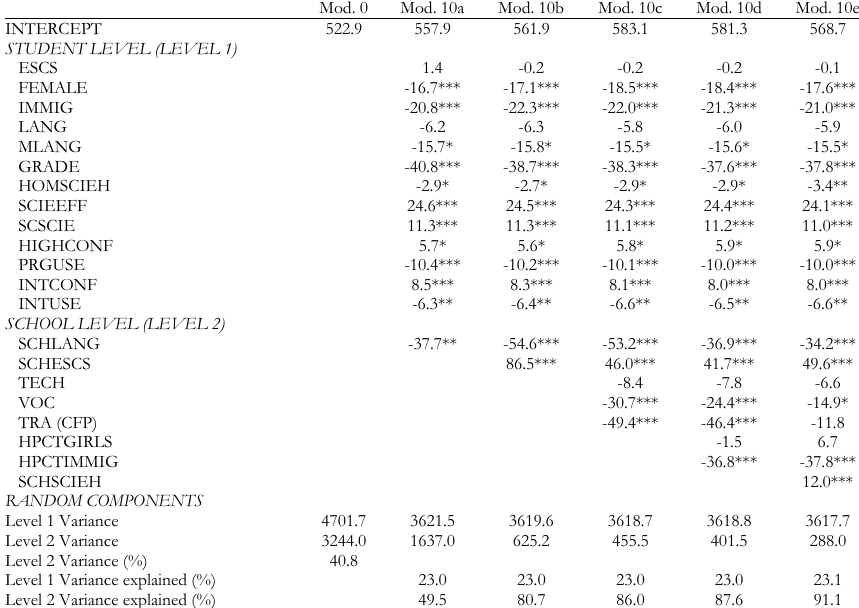
Net effects of level 1and level 2 variables on science